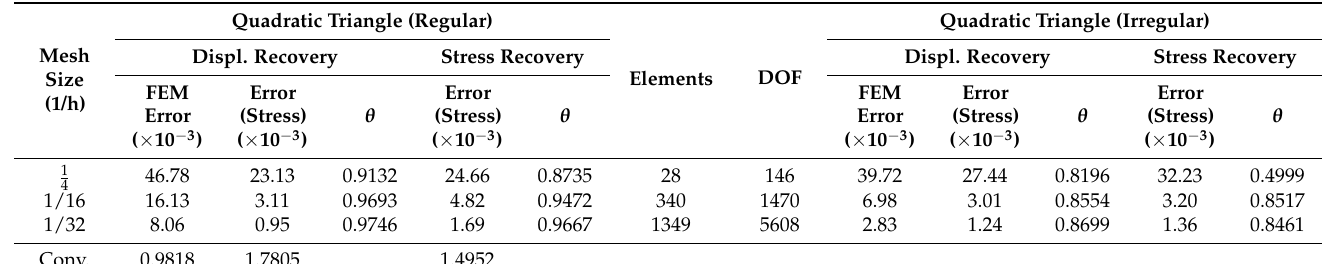
Table 10. Error in stress (L 2 -Norm) and global effectivity ( θ ) in incompressible elastic square plate example considering displacement and stress recovery technique for Quadratic Triangular mesh (Regular/irregular).